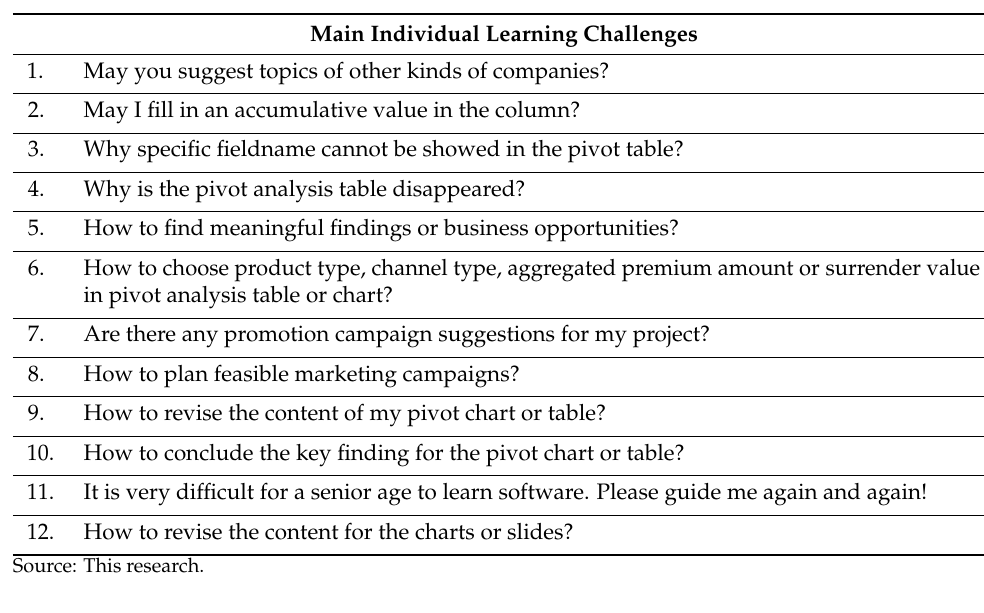
Table 4. Individual learning challenges for students.